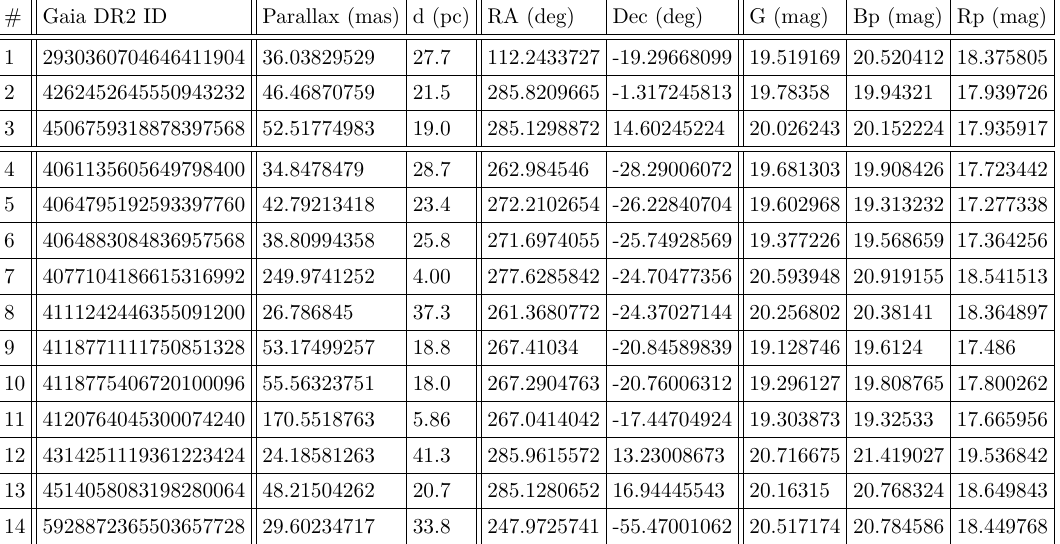
Table 1. This table contains the Gaia designation, parallax, right ascension, declination, g mag, bp mag, and rp mag for each of the mirror star candidates. The first candidate (label in bold) is